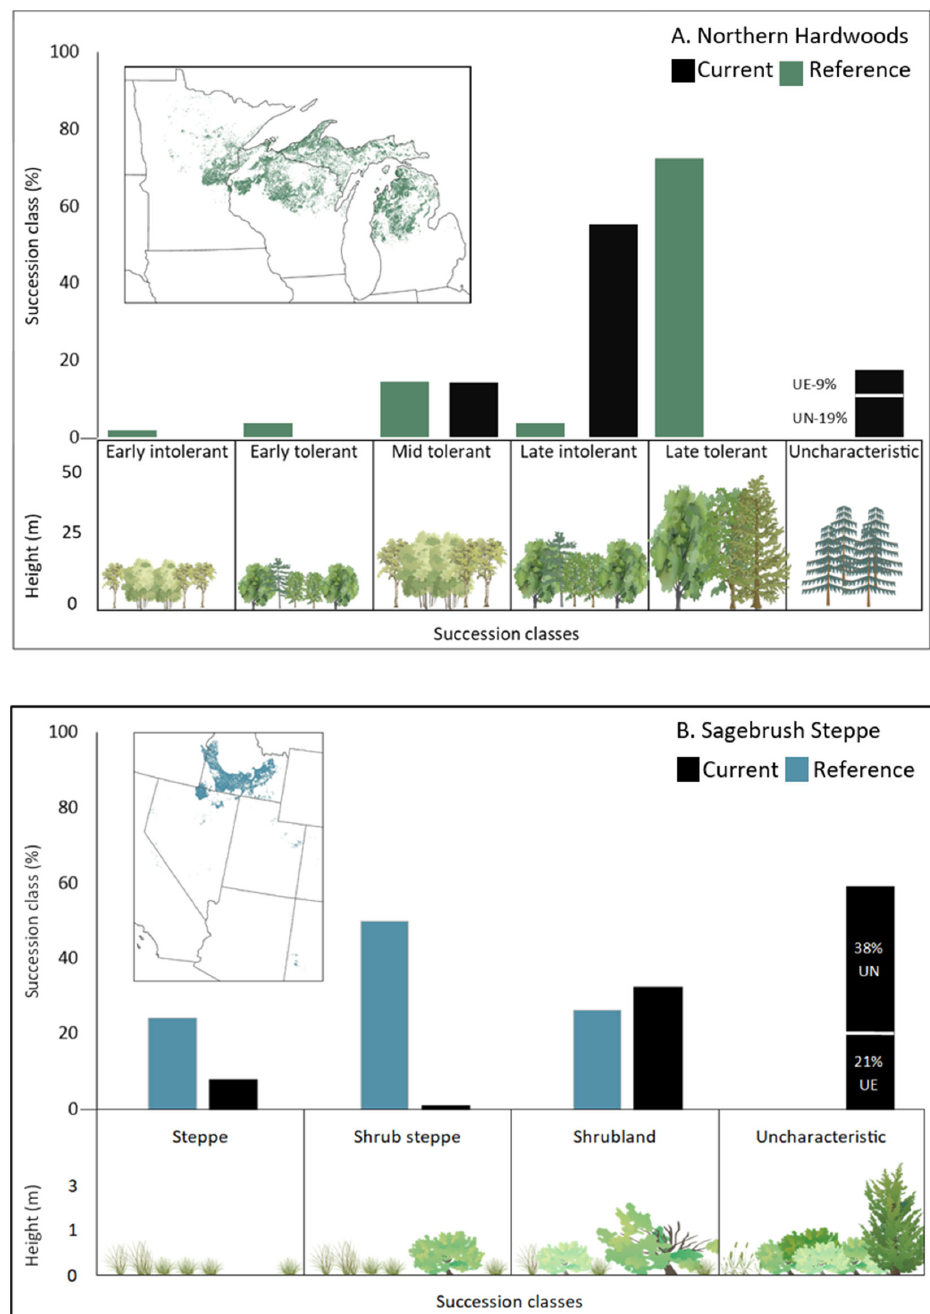
Figure 3. A comparison of reference and current structural stage (i.e., succession class) amounts for A) Northern Hardwoods and B) Sagebrush Steppe show high vegetation departure. Each panel has a map representing the ecological extent, depictions of the individual structural stages (names shortened), and a bar chart comparing reference to current amounts of each structural stage. Vegetation graphics credit: Integration and Application Network (ian.umces.edu/media ‐ library).